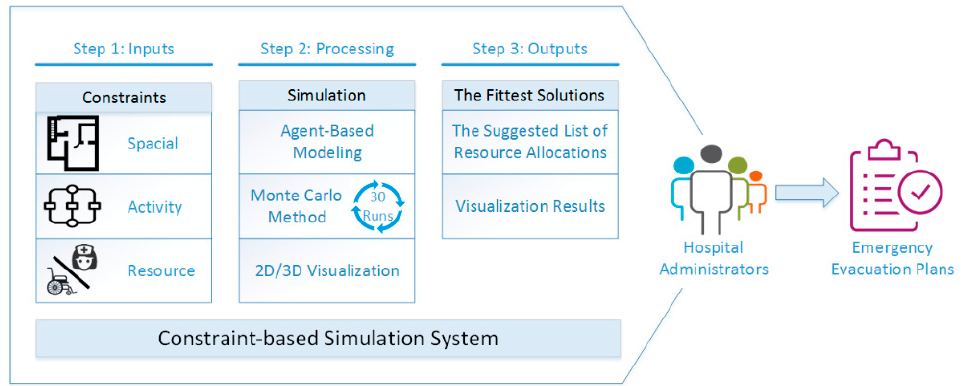
Figure 1. The research framework of the proposed method.